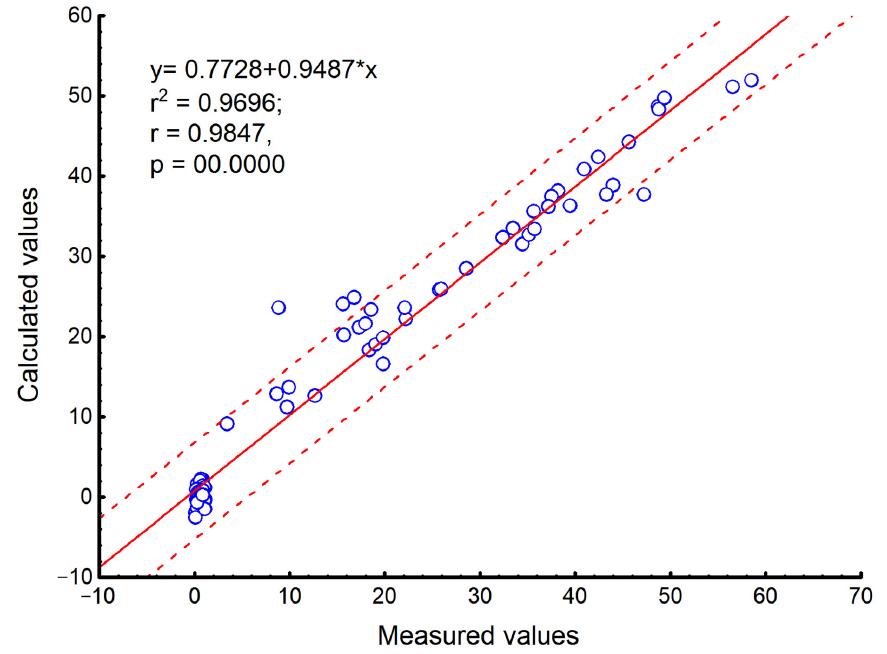
Figure 11. Scatter diagram for calculated values versus measured values of specific diagnostic indexes of detrital mica in the very fine sand fraction from sediments of the Subei littoral plain area (95% confidence).